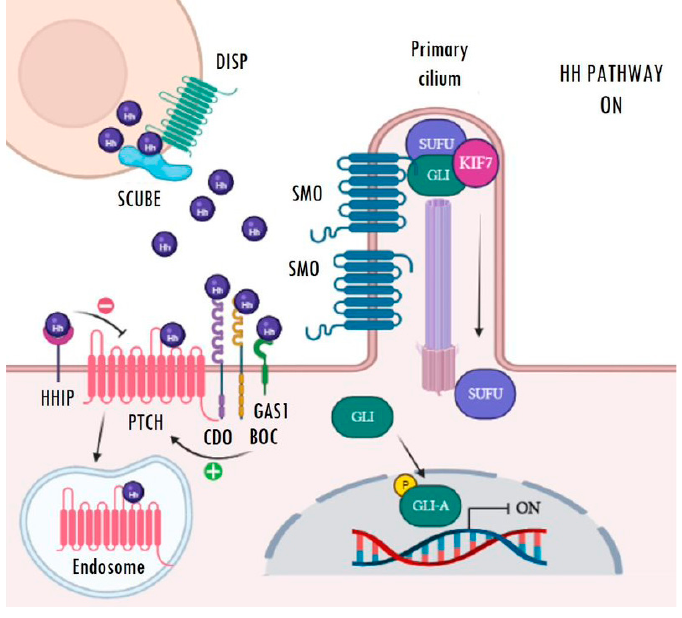
Figure 2. Active Hedgehog signalling. Binding of Hh ligands (purple spheres) to PTCH causes its internalization and subsequent endosomal degradation. Then, SMO moves and accumulates in the primary cilium, where it releases the GLI transcription factors from the repressor complex. Finally, active GLI proteins (GLI-A) translocate to the nucleus, where they are able to activate the transcription of Hh target genes. Image created with BioRender (BioRender.com).